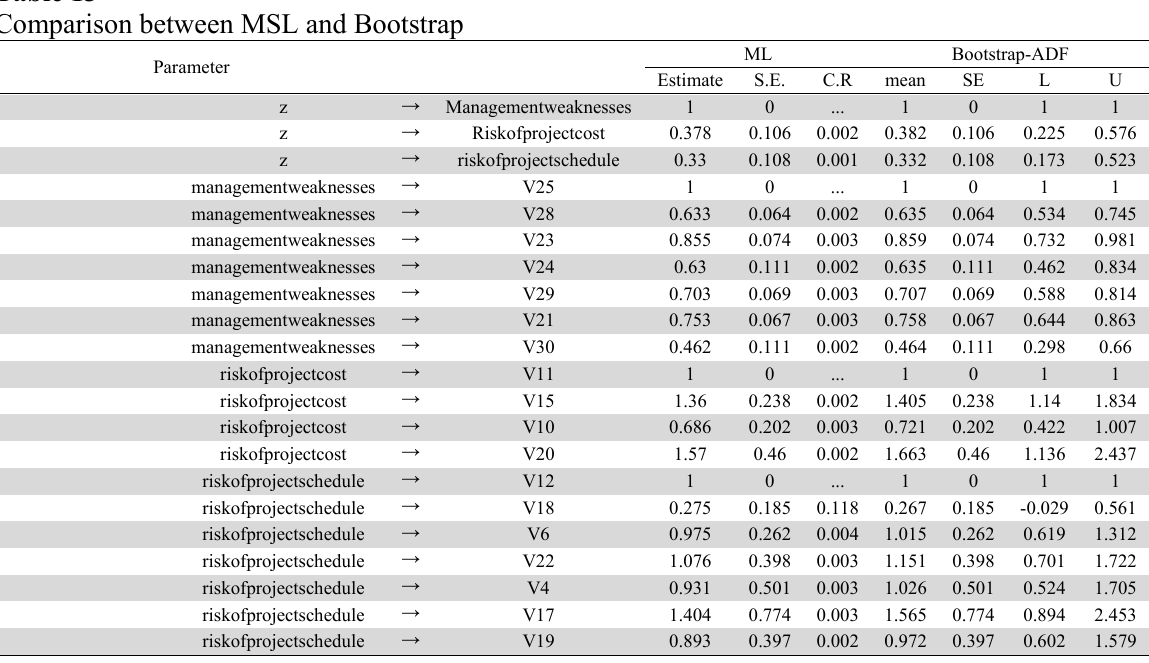
Comparison between MSL and